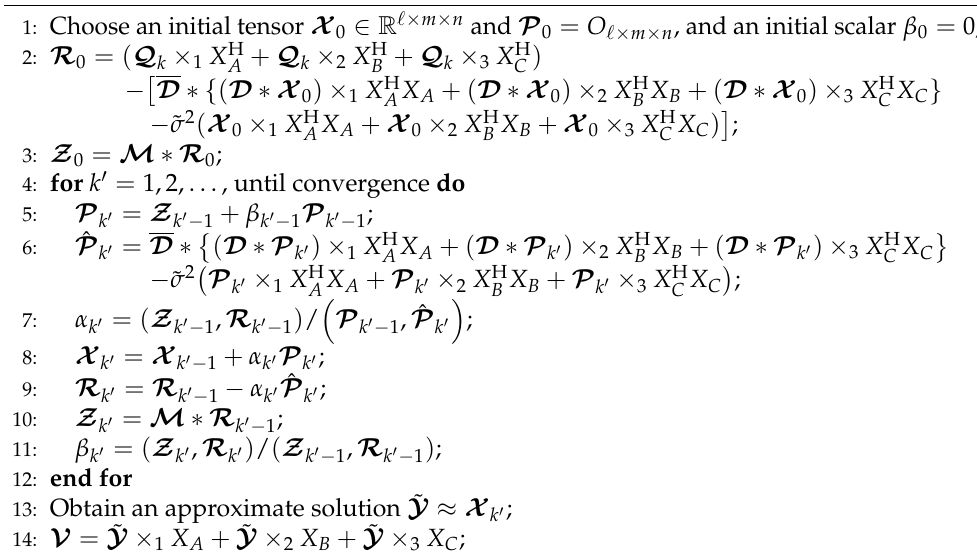
Algorithm 3: PCG method over tensor space for the 5-th line of Algorithm 1 [Pro- posed inner algorithm using the